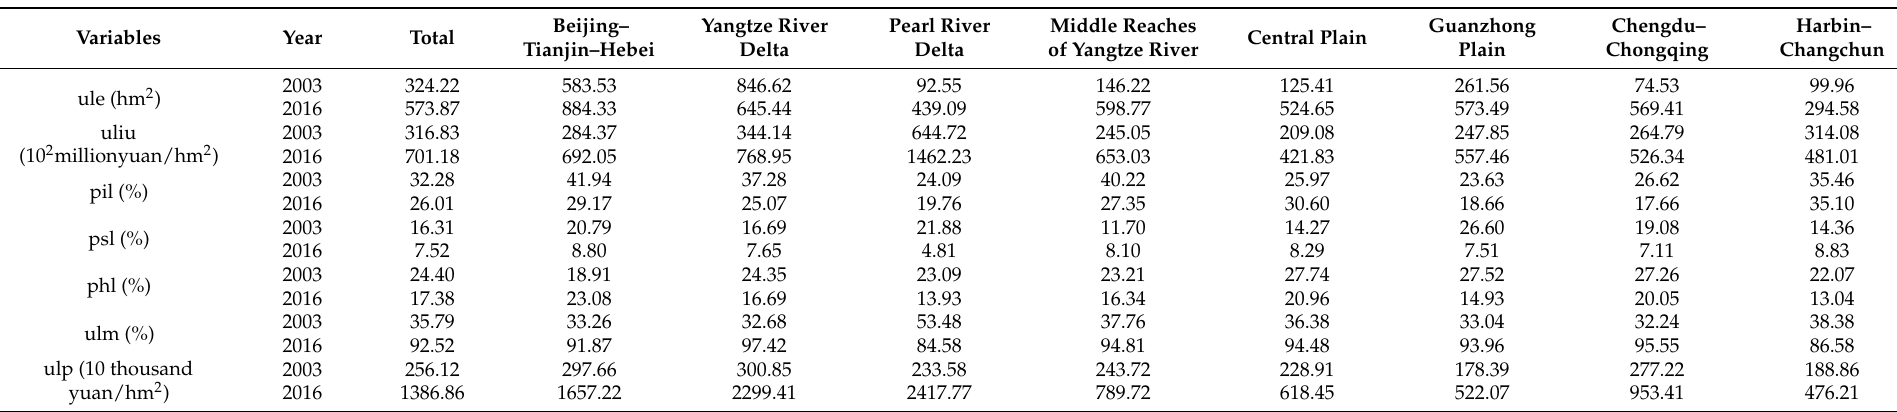
Table 1. Mean value of ULUT.